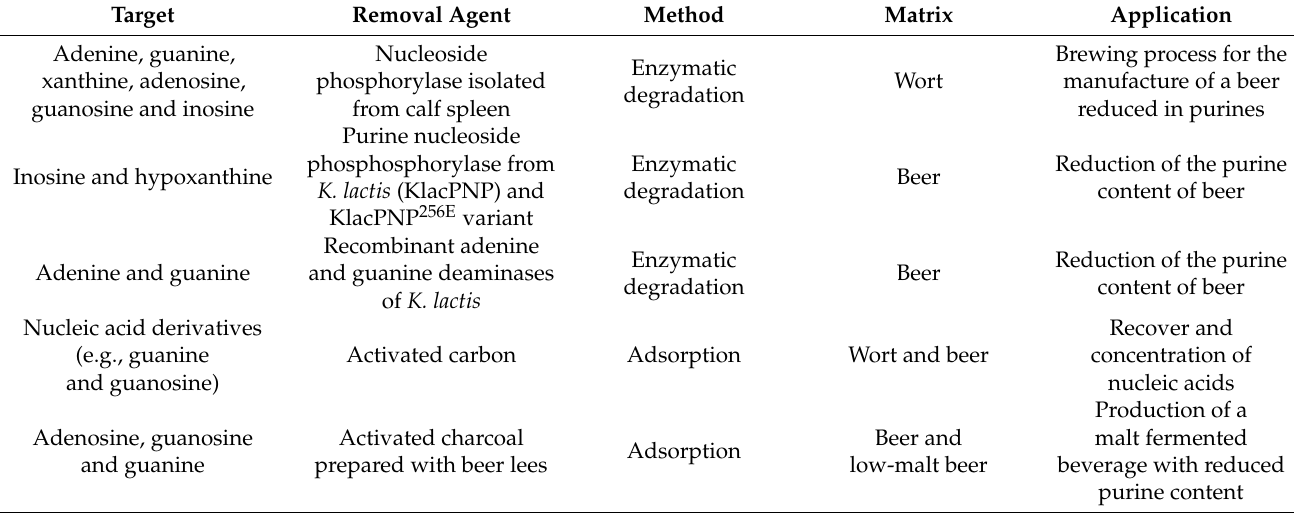
Table 5. Removal-based methodologies of purine compounds from beer [65,96,99,104,105]. Target Removal Agent Method Matrix